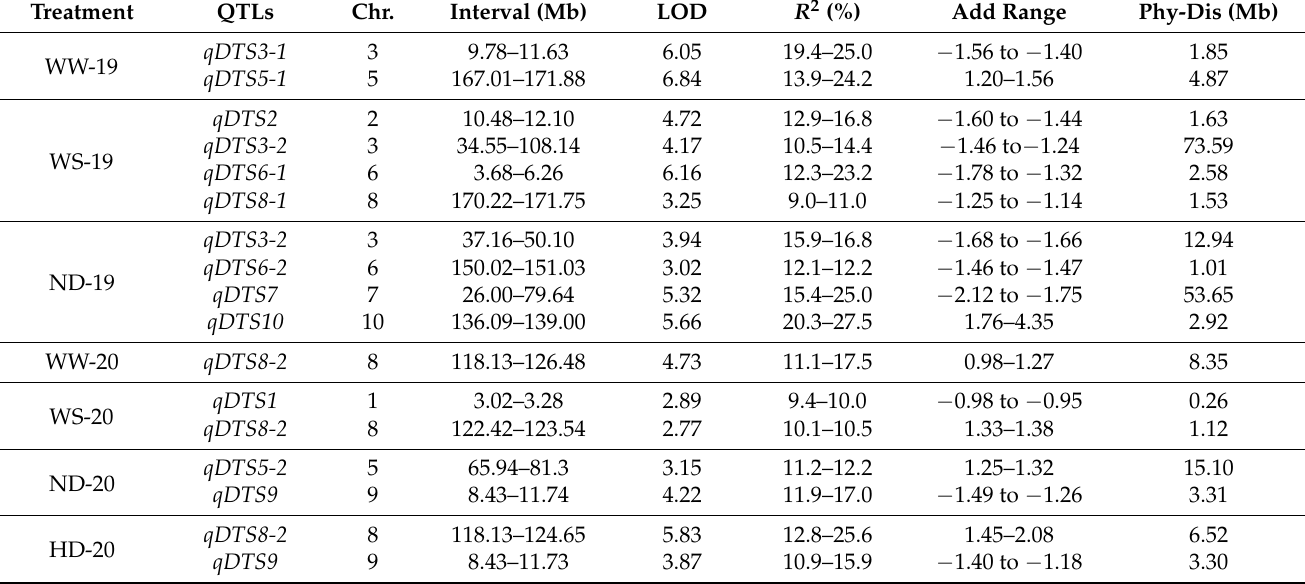
Table 3. QTLs identified for DTS under two water regimes and planting densities during 2019 and 2020.